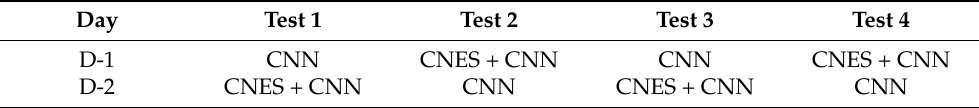
Table 5. The experimental plan for real-time testing.